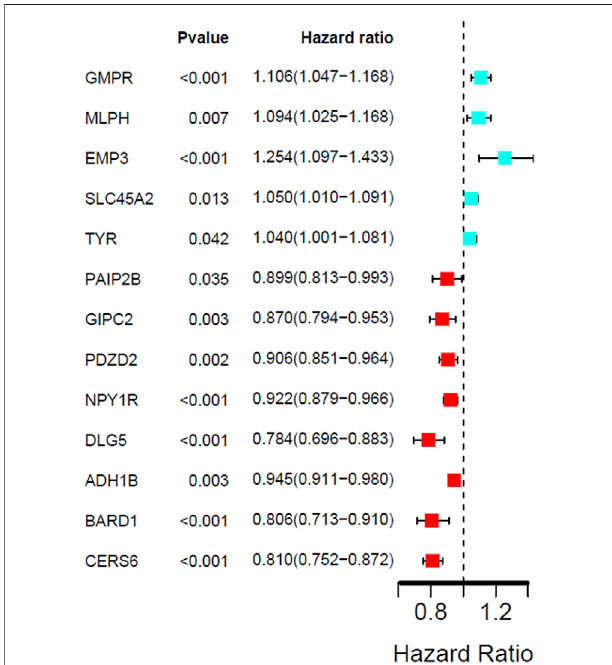
FIGURE 4 | Univariate Cox regression analysis showing the hazard ratios (HRs) with 95% con fi dence intervals (CIs) and p values for 13 DEGs.